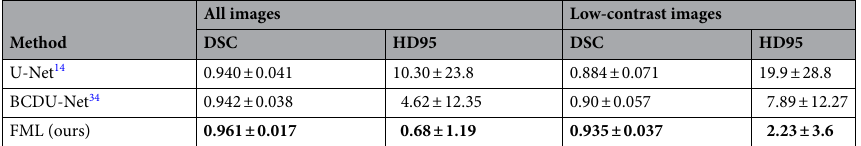
Table 3. Comparison between the segmentation accuracy of the FML method versus U-Net and BCDU-Net models. Significant values are in [bold].